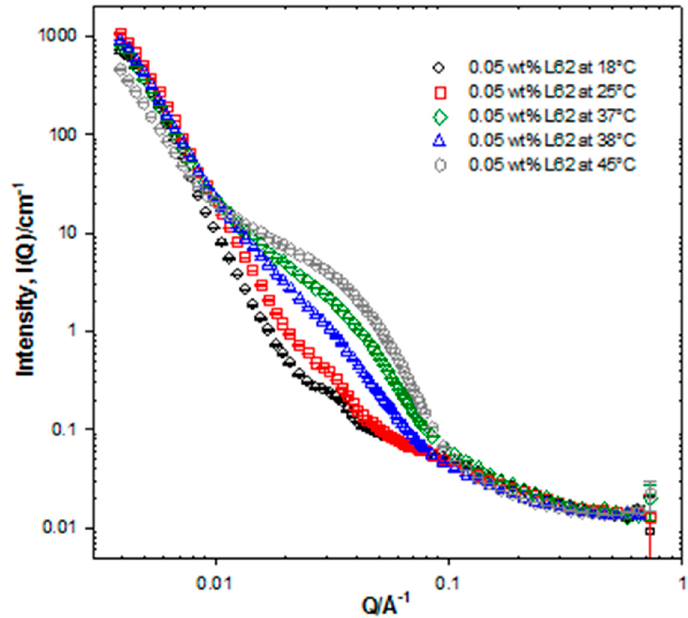
Figure 4. Small-angle scattering presented in the conventional, double logarithmic I ( Q ) vs. Q format arising from Pluronic L62 as a function of temperature, background corrected. All samples were prepared in D 2 O.